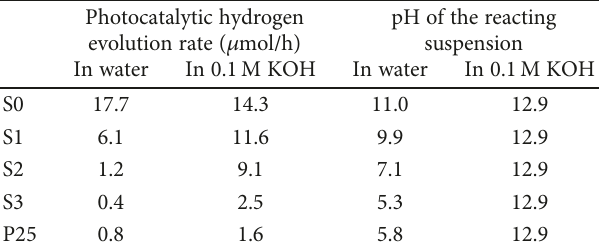
Figure 5: Kinetic curves of hydrogen evolution over Rb solution in water (a) and 0.1M KOH